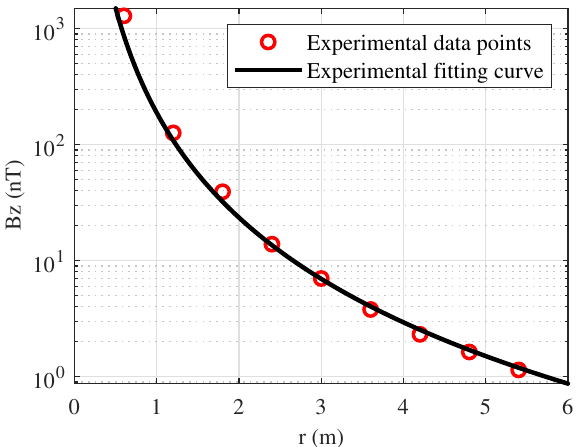
Figure 10. The change in B z -field with